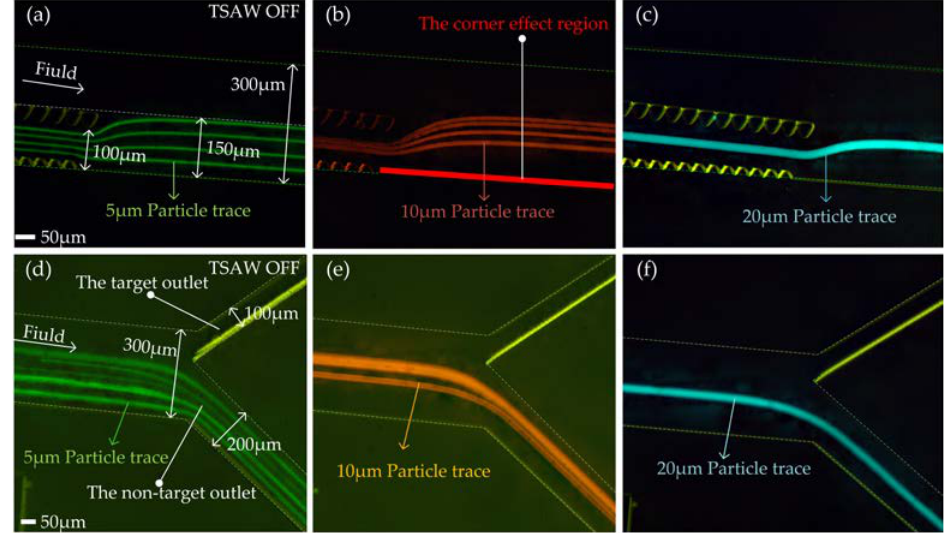
Figure 6. The test effect diagram after superimposing the particle tracks of each particle size: ( a ) 5 µ m particle tracks test diagram at the end of micropillar; ( b ) 10 µ m particle tracks test diagram at the end of micropillar; ( c ) 20 µ m particle tracks test diagram at the end of micropillar; ( d ) 5 µ m particle tracks test diagram at the outlet of the flow channel; ( e ) 10 µ m particle tracks test diagram at the outlet of the flow channel; ( f ) 20 µ m particle tracks test diagram at the outlet of the flow channel.